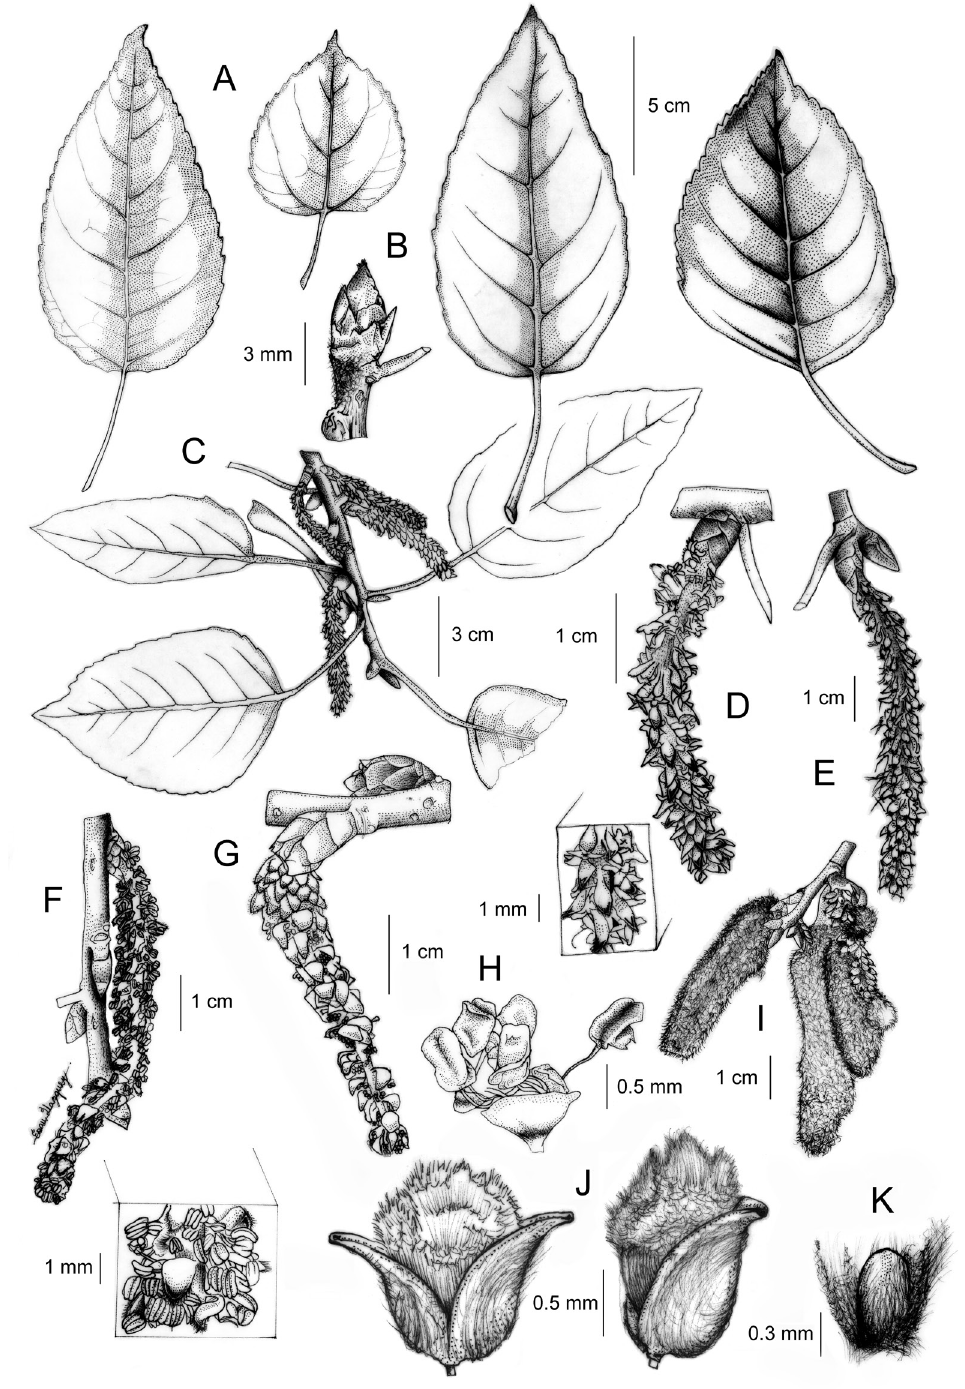
Fig. 1. Populus primaveralepensis A.Vázquez, Muñiz-Castro & Zuno sp. nov. A–E , I–K . Vázquez- García et al. 10106c leg., IBUG. F–H . Vázquez-García et al. 10106b leg., IBUG. A . Variability of leaves. B . Leaf bud. C . Branch with female inflorescence. D–E . Early and late state of inflorescence. F–G . Late and early male inflorescence. H . Male flower. I . Infrutescence with pappus. J . Capsule complete and in half, with pappus. K . Developing gynoecium. Illustrations: E. E.